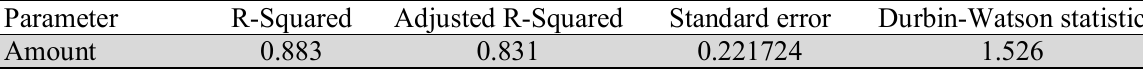
Evaluation of residuals autocorrelation Parameter